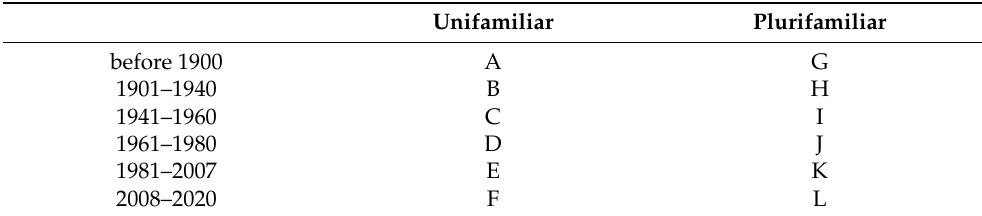
Table 2. List of main building archetypes implemented and managed in the PEDRERA model. Source: urbanZEB web